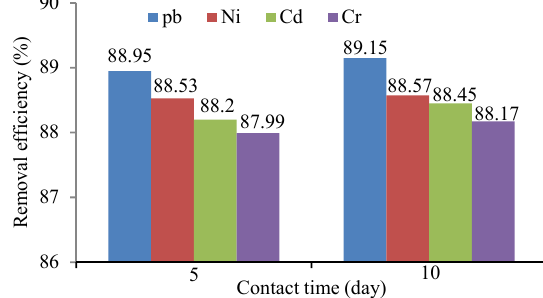
Fig. 3. Duckweed efficiency in combined heavy metal removal at concentration of 10 mg/l (duckweed weigh: 1.2 g)